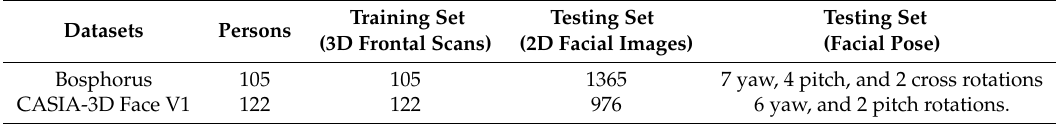
Table 1. A brief summary of the datasets in our experiments.